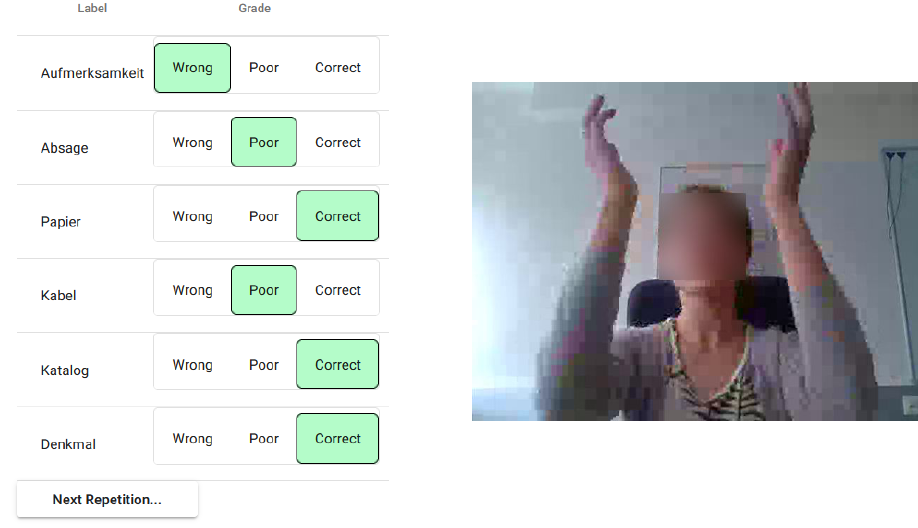
Figure 6. The instructor’s web interface for reviewing and labeling GEC executions.